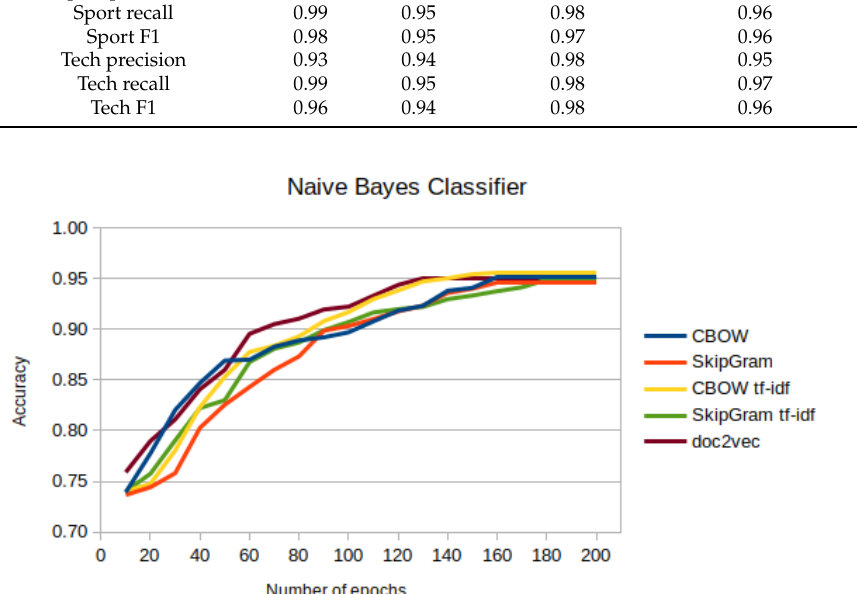
Figure 5. Accuracy of Naive Bayesian Classifier classification for selected text vectorization methods by